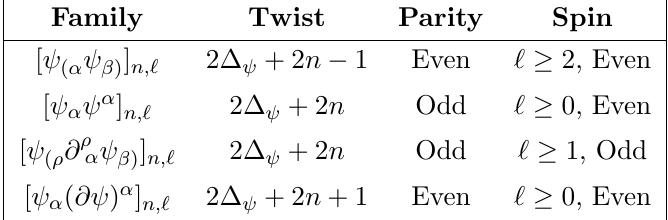
Table 3 . We list the di(cid:11)erent double-twist families for Majorana fermions in 3d, with their twist accumulation points, parities, and